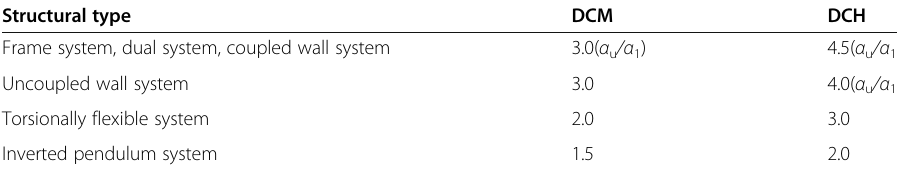
Table 2 Basic values of the seismic reduction factor, R , for systems regular in elevation [17]